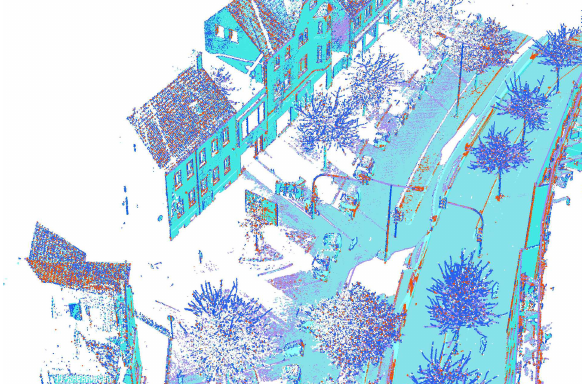
Figure 1. Raw classification into volumetric (red), linear (dark blue) and planar (light blue) patterns using a 10 cm radius search.